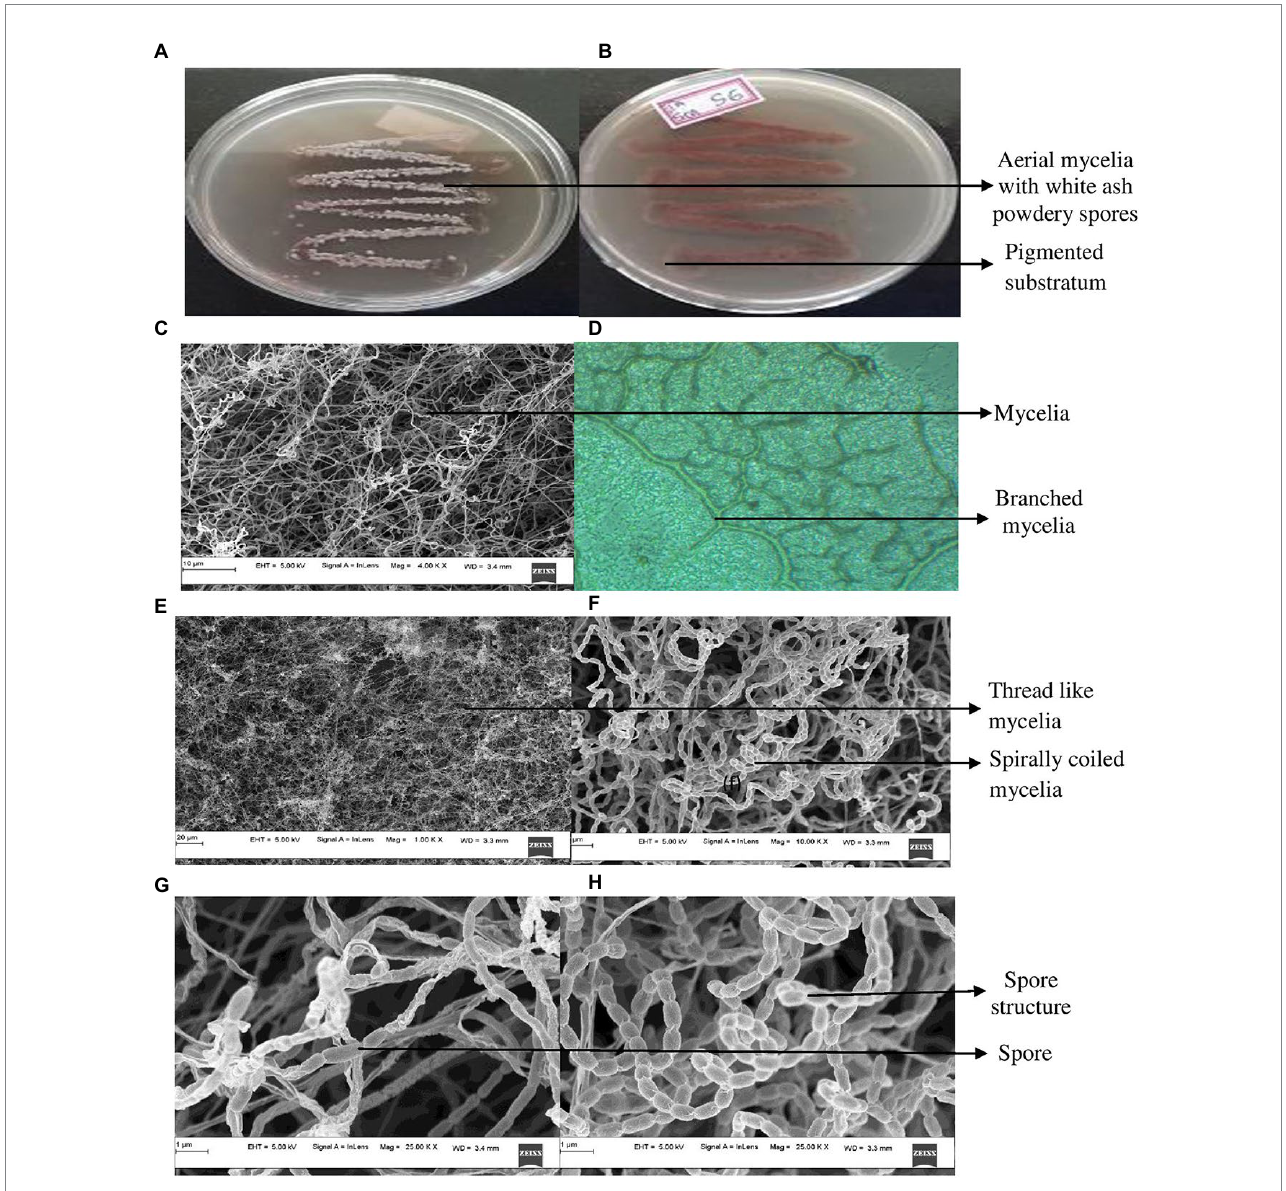
FIGURE 1 Cultural characteristics of Glutamicibacter mysorens . (A) Front view of isolate. (B) Rear view of isolate. (C) Mycelia observations under FESEM. (D) Phase contrast microscopic analysis. (E,F) Mycelia along with spore analysis under FESEM. (G,H) Spore structure analysis using